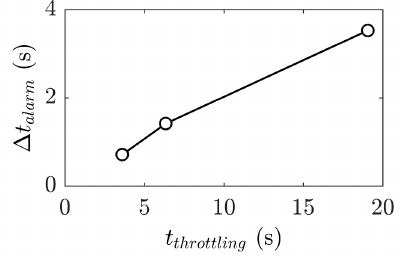
Figure16. Evolutionwarningtime ∆ t alarm asafunctionoft throttling forthe3continuousthrottlingspeeds. Figure 16. Evolution warning time Δ t alarm as a function of t throttling for the 3 continuous throttling speeds.